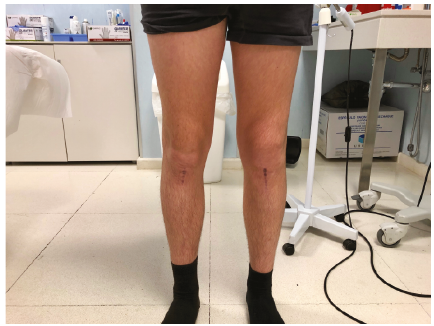
Figure 4: Patient at the o ffi ce. Nonsymptomatic hypertrophic scar is